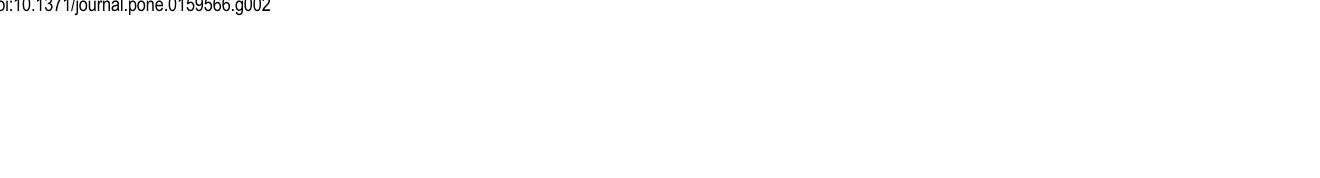
PLOS ONE | DOI:10.1371/journal.pone.0159566 July 21,